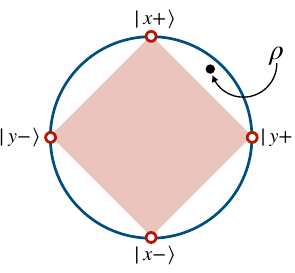
FIG. 8. Nonconvex decomposition. All states in the x - y plane of the Bloch sphere, including the pure states, can be described by the basis state ˆ (cid:15) 1 , ˆ (cid:15) 2 , and ˆ (cid:15) 4 in Eq. (69). However, only the states in shaded region will be convex mixtures of these basis states. Of course, no pure state can be expressed as a convex